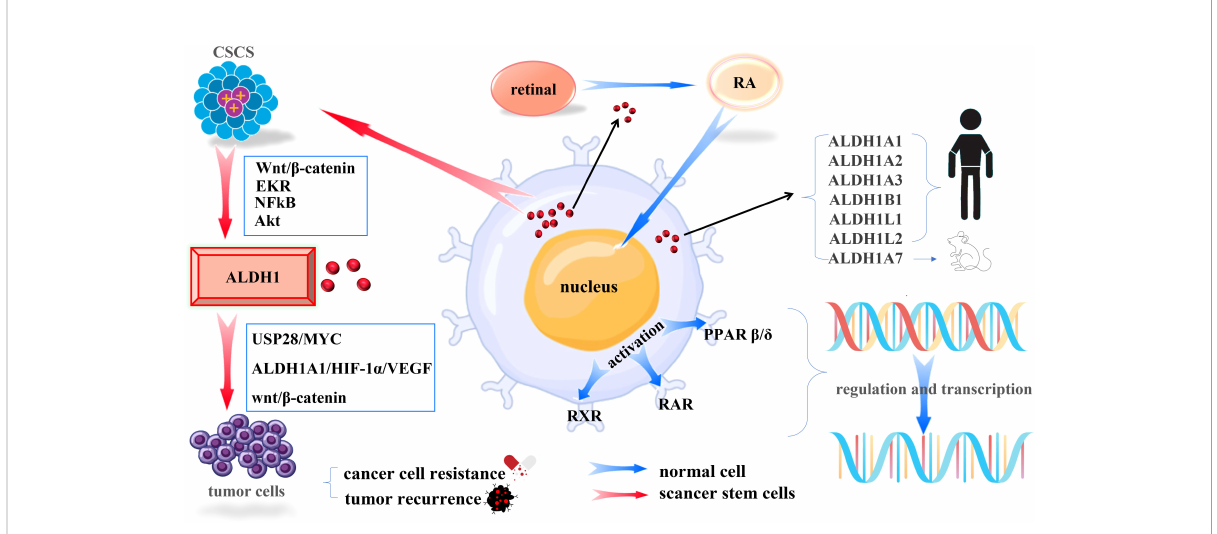
FIGURE 1 Mechanisms of ALDH1 in Cells. (Blue arrows indicate the mechanism of action of ALDH1 in normal tissues, red arrows indicate the mechanism of action of ALDH1 in cancer stem